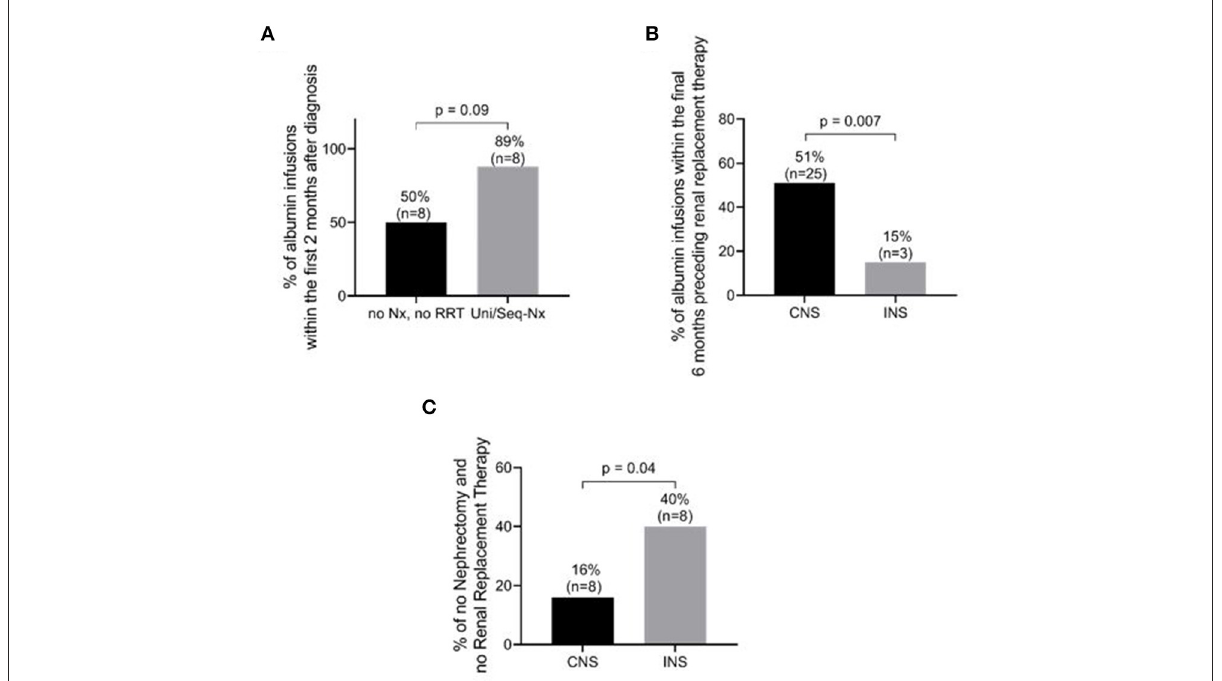
FIGURE4 Management and outcome differences between patients with congenital nephrotic syndrome (CNS) and those with infantile nephrotic syndrome (INS). (A) Percentage of patients requiring albumin infusions within the first 2 months after diagnosis in CNS + INS patients. Patients with unilateral/sequential nephrectomy tended to receive more frequent albumin infusions than patients without nephrectomy and RRT ( P = 0.09) (B) Percentage of patients requiring albumin infusion within the 6 months preceding RRT. CNS patients were more likely to require albumin infusions ( p = 0.007). (C) Percentage of patients without nephrectomy and without renal replacement therapy (RRT). INS patients required fewer interventions than CNS patients ( p = 0.04). See details in text and Table 2 regarding frequency of infusions. Nx, nephrectomy; Uni/Seq-Nx, unilateral/sequential